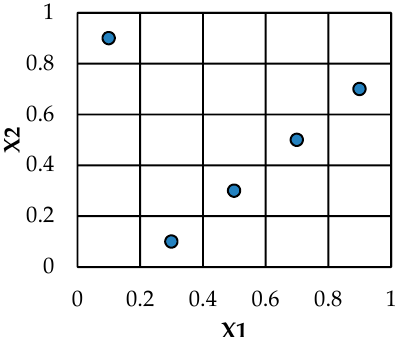
Figure 2. A Latin hypercube sample distributed uniformly on the unit square.